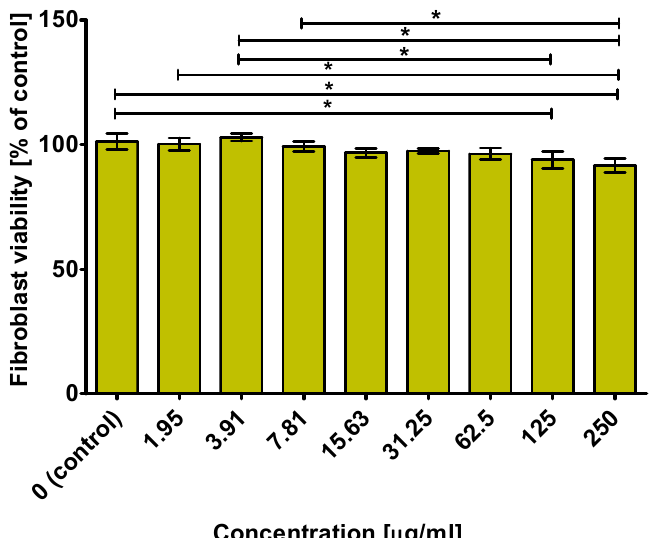
Figure 4. Fibroblast viability after 48 h incubation with extract from N. officinale grown with 3.0 mM Phe (day 0). The results were obtained using MTT assay. * Significantly different data between tested groups. p < 0.05; one-way ANOVA followed by Tukey’s multiple comparison